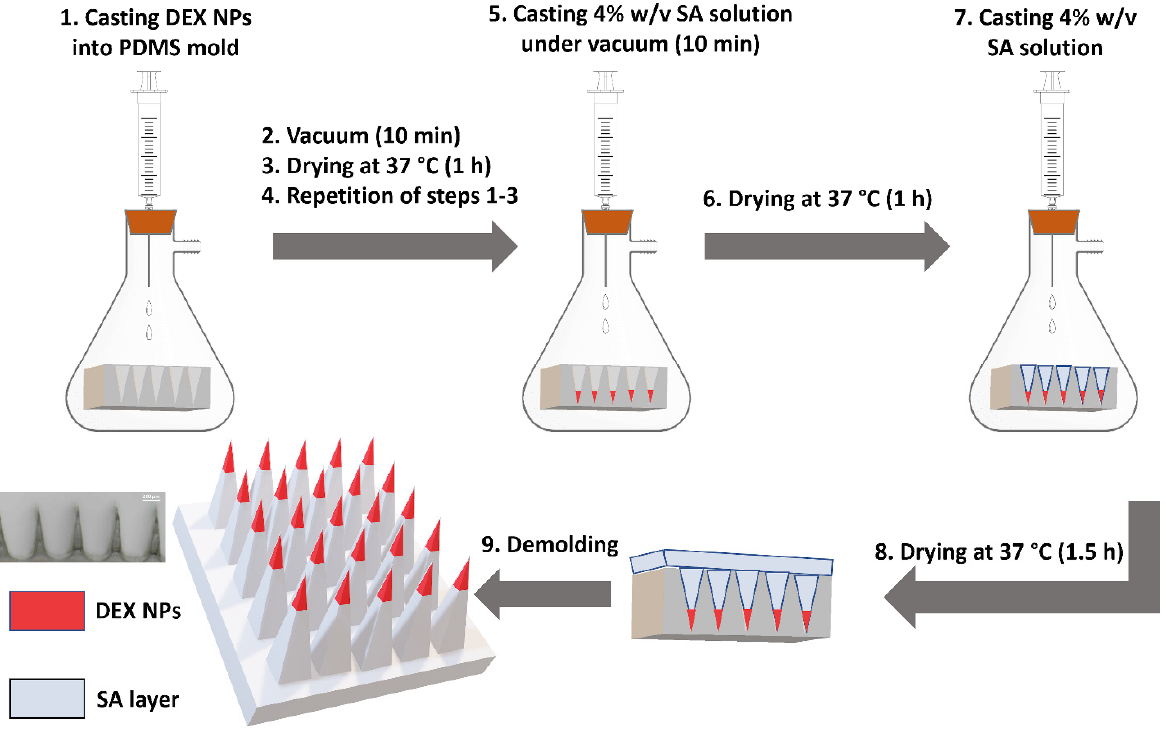
Figure 1. Preparation scheme of NP-loaded MNs by a vacuum-deposition micromolding method using a polydimethylsiloxane (PDMS) microneedle mold.